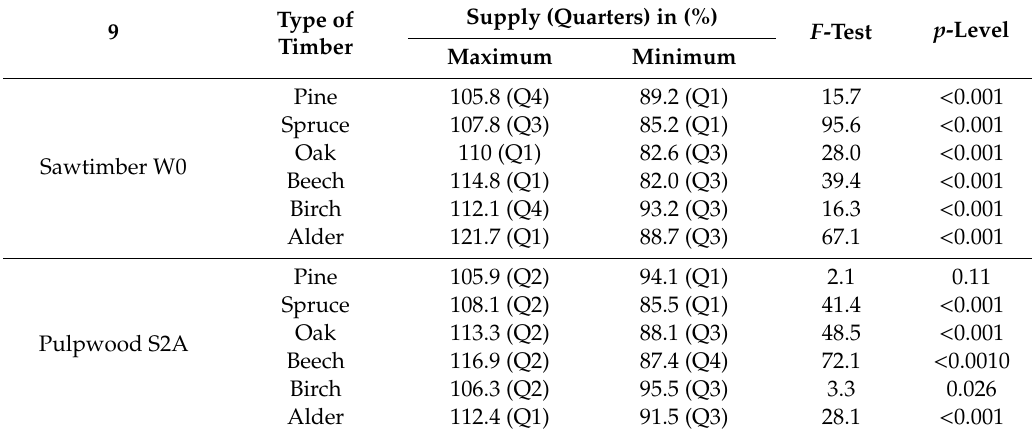
Table 4. Seasonal fluctuations in large-diameter timber (W0) and pulpwood (S2A).